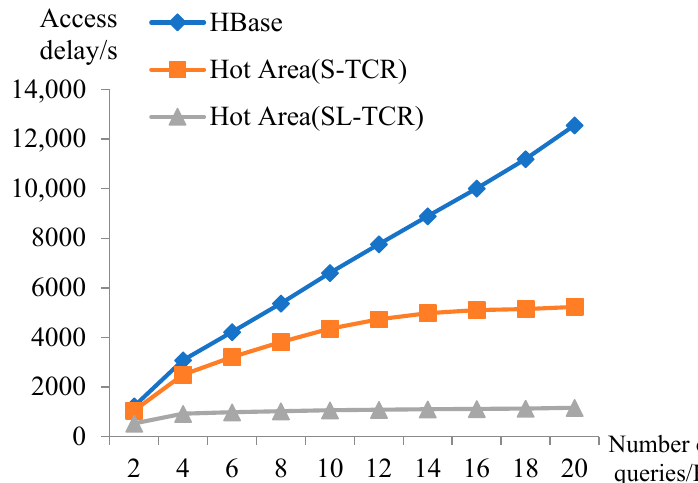
Figure 14. Hit rate comparison of three algorithms.